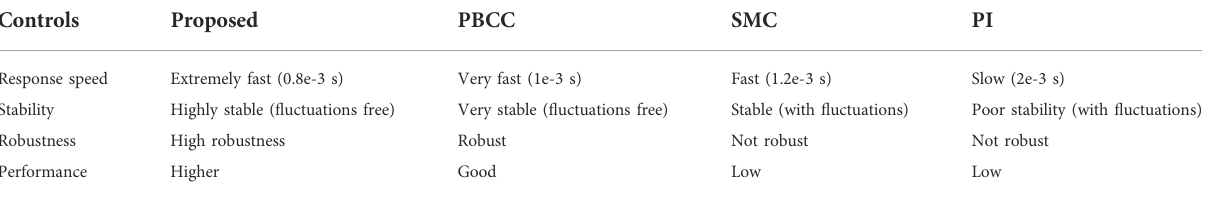
TABLE 4 Performance comparisons of the tested controls.